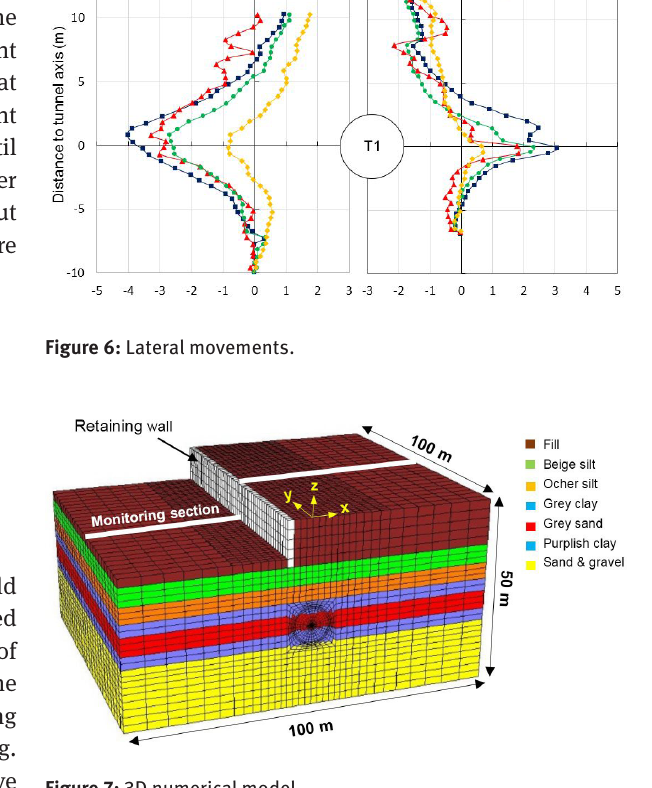
Figure 7: 3D numerical